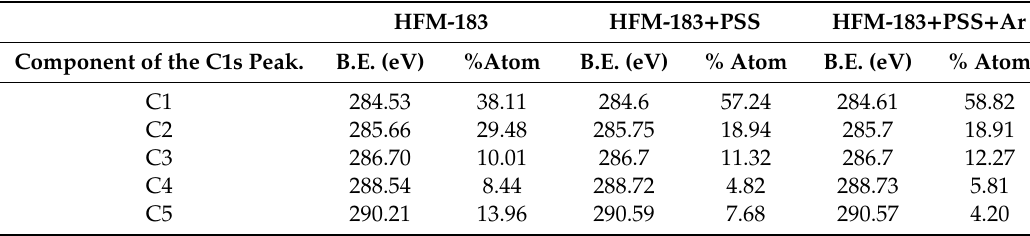
Table 5. Deconvolution of the C1s peak. B.E. stands for binding energy. HFM-183 HFM-183 + PSS HFM-183 + PSS + Ar Component of the C1s Peak.